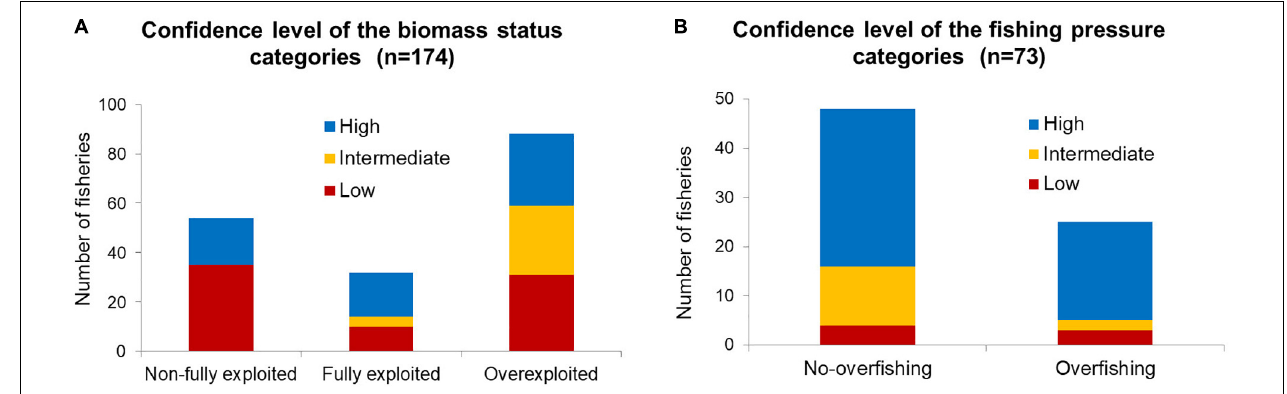
FIGURE 4 | Confidence level of the biomass stock status (A) and the fishing pressure (B) categories assigned to the snapper and grouper fisheries evaluated in this